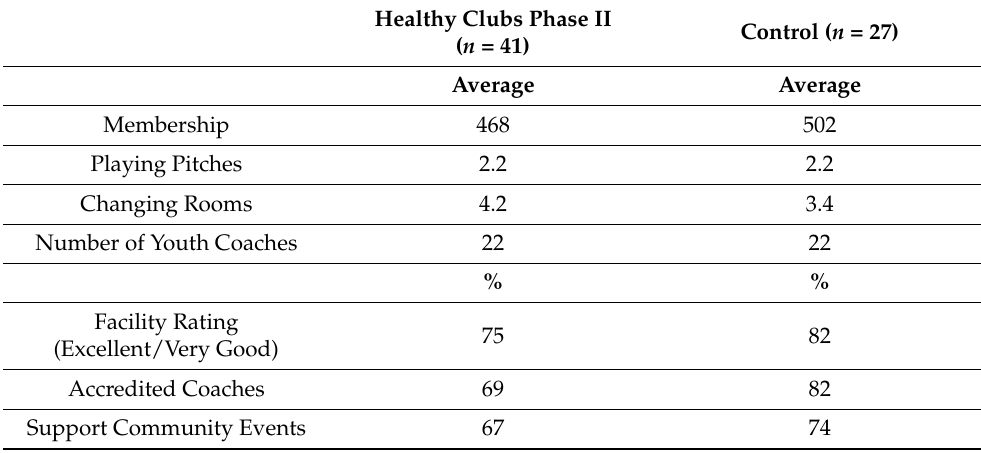
Table 1. Descriptive characteristics of healthy and control clubs at baseline ( n =